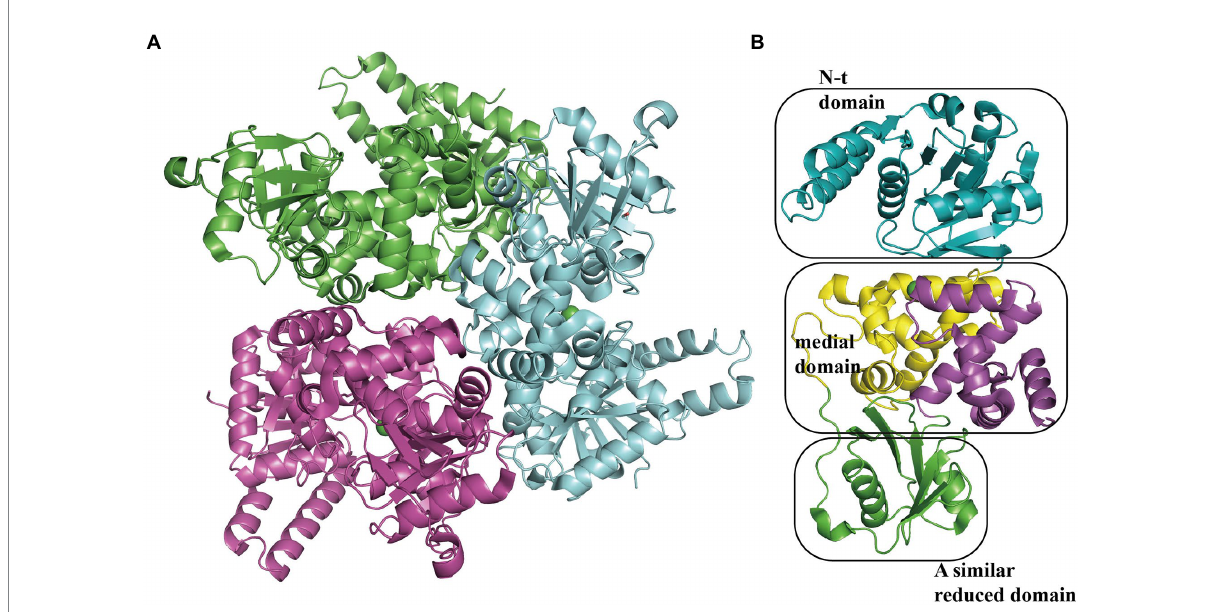
FIGURE 10 Overall structure of PaaH. (A) The overall structure of the EcoPaaH trimer (PDB:3MOG). The PaaH trimer reveals a central symmetric structure in space, shown in green, magenta, and teal by chains. (B) The PaaH monomer is constructed from three regions, N-terminal domain, and a reduced domain (mainly consisting of a β -sheet surrounded by α -helices) in teal and green, respectively. In addition, a medial region consists of two discontinuous parts sharing a similar five-helixes structure which could be seen as a ‘dimer’ conformation, shown in yellow and magenta in each part,